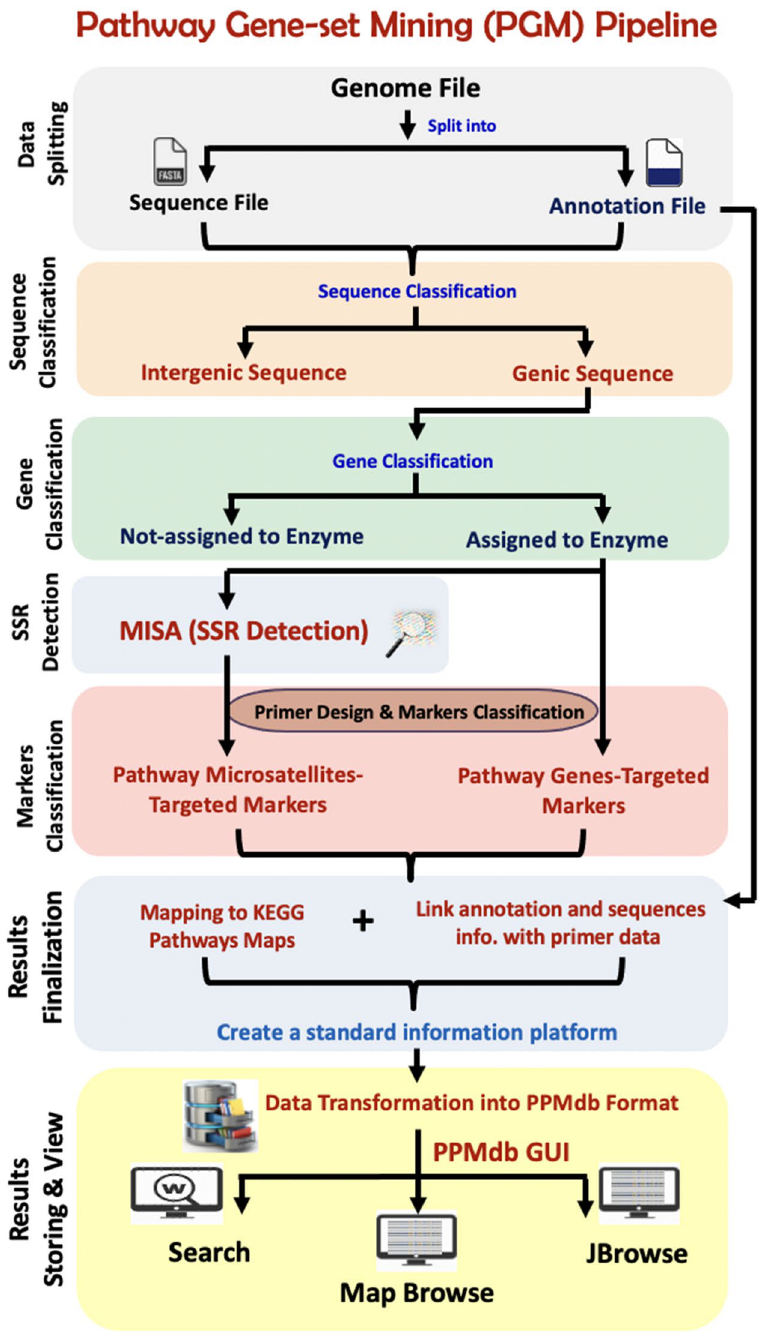
Figure 1. The workflow of pathway gene-set mining (PGM)